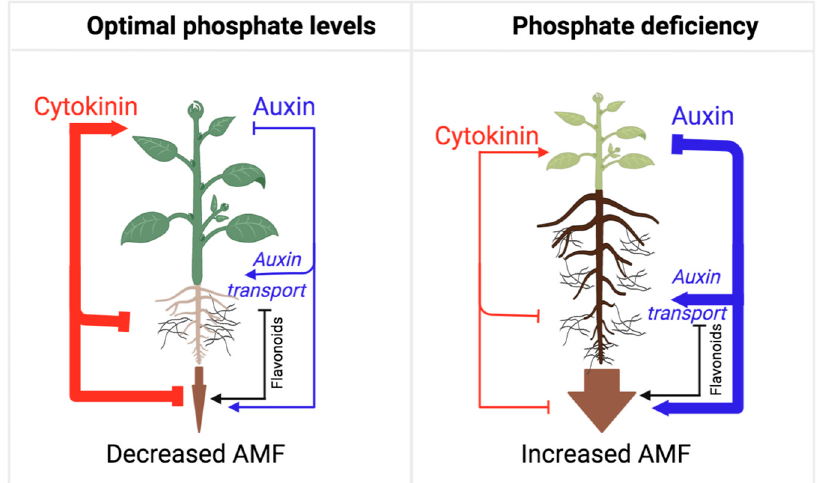
Figure 3. Model illustrating the auxin/cytokinin ratios during the establishment of AMF symbiosis from the perspective of adaptive control of the shoot/root growth ratio. As long as the plant perceives phosphate deficiency in the soil, the rate of AMF symbiosis establishment is high, mirroring a low shoot/root growth ratio and the allocation of resources towards root growth and fungal colonization. Under phosphate-deficient conditions, auxin action is high, which represses cytokinin action and shoot growth in favor of root growth and symbiosis. Under phosphate-sufficient conditions, auxin action is reduced, and cytokinin action is released to promote shoot growth, inhibit root growth, and suppress AMF symbiosis. Flavonoids play an essential role in this process, as they promote several stages of this symbiotic interaction.